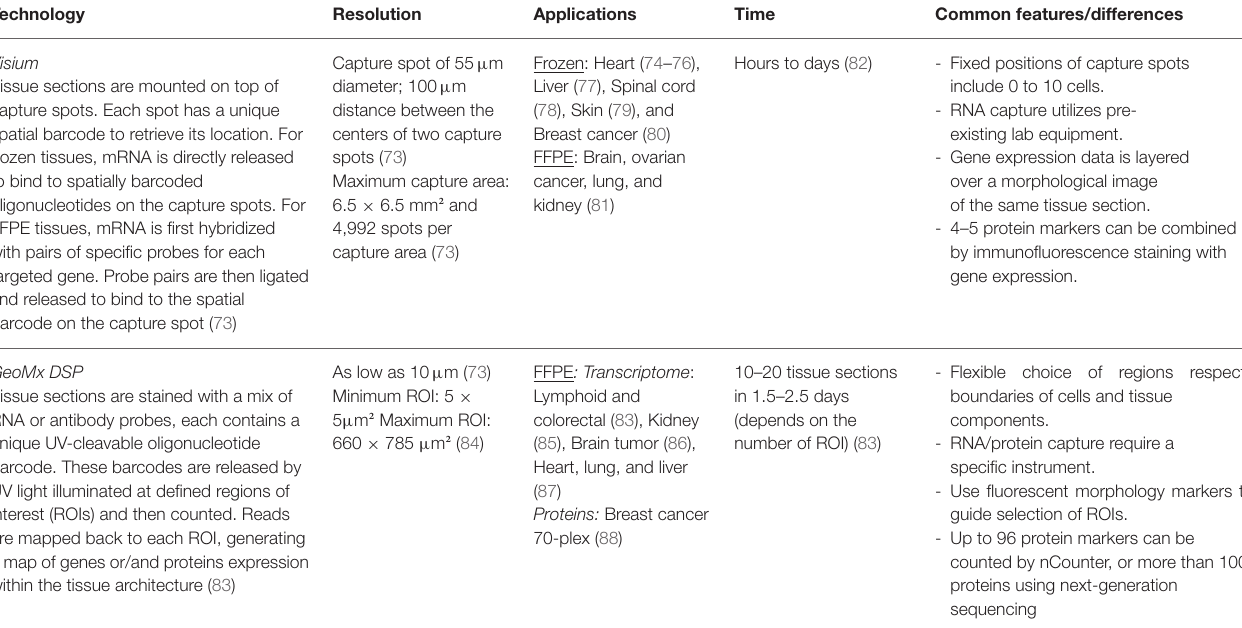
TABLE 1 | Spatial gene expression technologies. Technology Resolution Applications Time Common features/differences Visium Tissue sections are mounted on top of capture spots. Each spot has a unique distance between the spatial barcode to retrieve its location. For centers of two capture